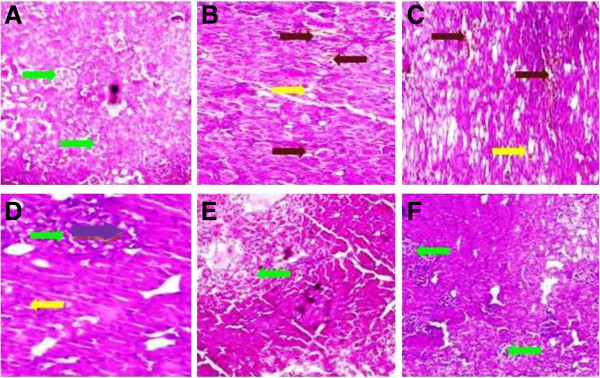
Effect of Melastoma malabathricum Linn. (MM) on kidney in different groups of rat: (A) Normal control: Normal control histopathology shown 2–5 average size of glomerulus (green arrow) (B) Diabetic control: Diabetic control histopathology shown inflammatory cell in blood vessels (red arrow) and increase the deposition of fats (yellow arrow) (C) MM I (100 mg/kg): Tested drug histopathology shown inflammation in blood vessels (red arrow) and fat deposition (yellow arrow) (D) MM II (250 mg/kg): Tested drug histopathology shown fat deposition (yellow arrow) and increase size of glomerulus (violet arrow) (E) MM III (500 mg/kg): Tested drug histopathology shown normal kidney like the glibenclamide treated group (F) Glibenclamide (10 mg/kg): Glibenclamide treated animal histopathology shown the normal kidney. The samples were obtained from the same liver anatomical regions. For each group, 6 rats were examined and 50 pictures were taken. The above picture for each group was chosen randomly from the 80 pictures in this group. Original magnification, 10 × .